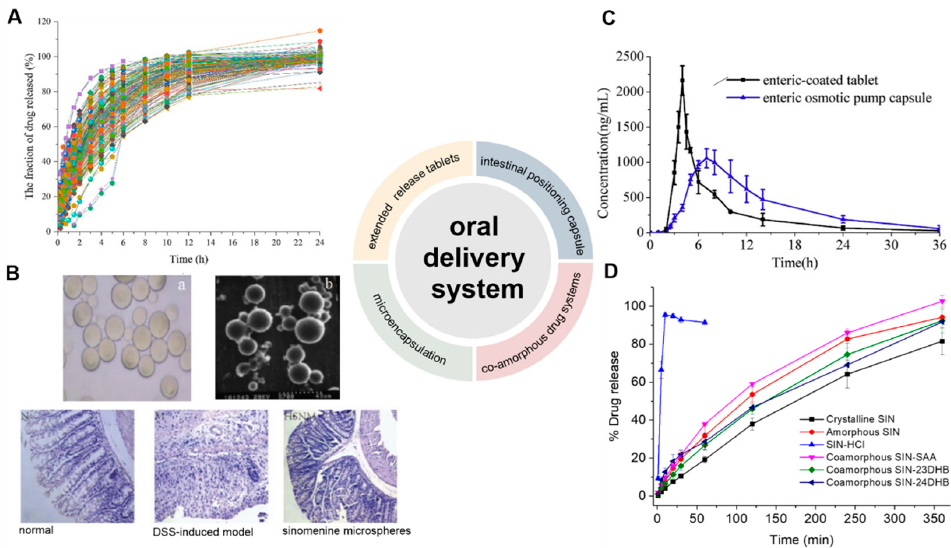
Figure 2. Development of oral administration systems of SIN. ( A ) Dissolution profiles of 36 batches of SIN-HCl sustained-release tablets showing complete drug release with a zero-order kinetics ( n = 5) [30]. The tablets consisted of with SIN-HCl, osmotic agents, and polymers for promoting permeation. ( B ) Light and electron microscope images of SIN microspheres, which exhibited improved treatment for DSS-induced mouse models by Hematoxylin–Eosin (H&E) staining of colon sections in different treatment groups [10]. ( C ) Plasma concentration–time curves of SIN from both enteric osmotic pump capsules or enteric-coated tablets in beagle dogs after oral administration ( n = 6) [28]. ( D ) Release profiles of SIN from crystalline SIN, amorphous SIN, SIN-HCl, as well as co-amorphous SIN and three different phenolic acids [37]. (Reprinted with permission form Refs. [10,28,30,37]).